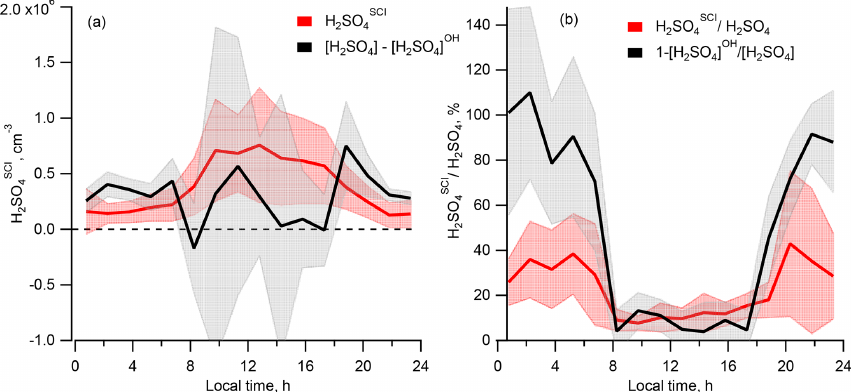
Figure 5. Comparison of the sulfuric acid produced by oxidation of SO 2 by SCIs, H 2 SO SCI from the difference of the measured [H 2 SO 4 ] and [H 2 SO 4 ] OH . (a) Diel profiles of the mean [H 2 SO 4 ] SCI (red) and [H 2 SO 4 ] − [H 2 SO 4 ] OH (black). (b) Diel profiles of the mean of the relative contributions [H 2 SO 4 ] SCI / [H 2 SO 4 ] (red) and 1 − [H 2 SO 4 ] OH / [H 2 SO 4 ] (black). Shaded areas correspond to ± 1 σ standard